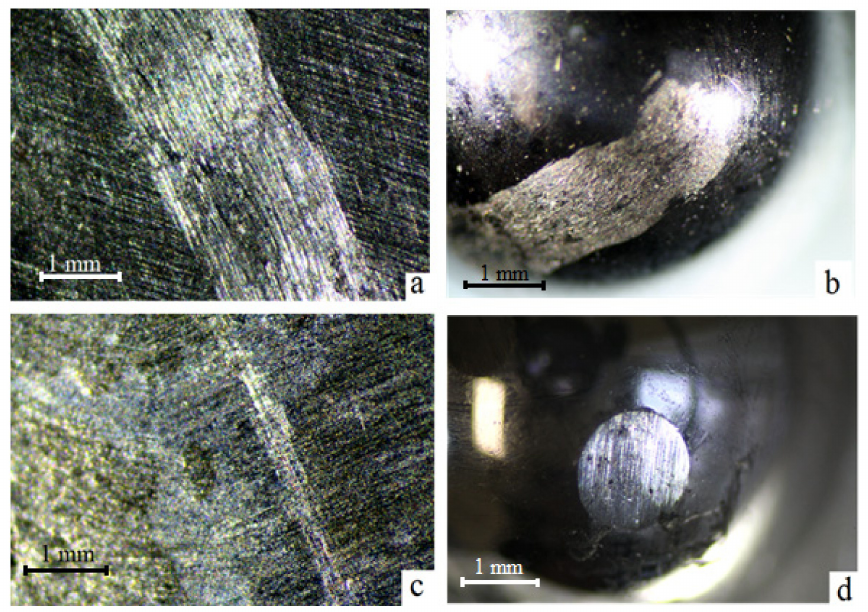
Figure 8. Friction tracks on samples and counter-body after tests: ( a , b ) initial samples; ( c , d ) treated samples (optical images, ×